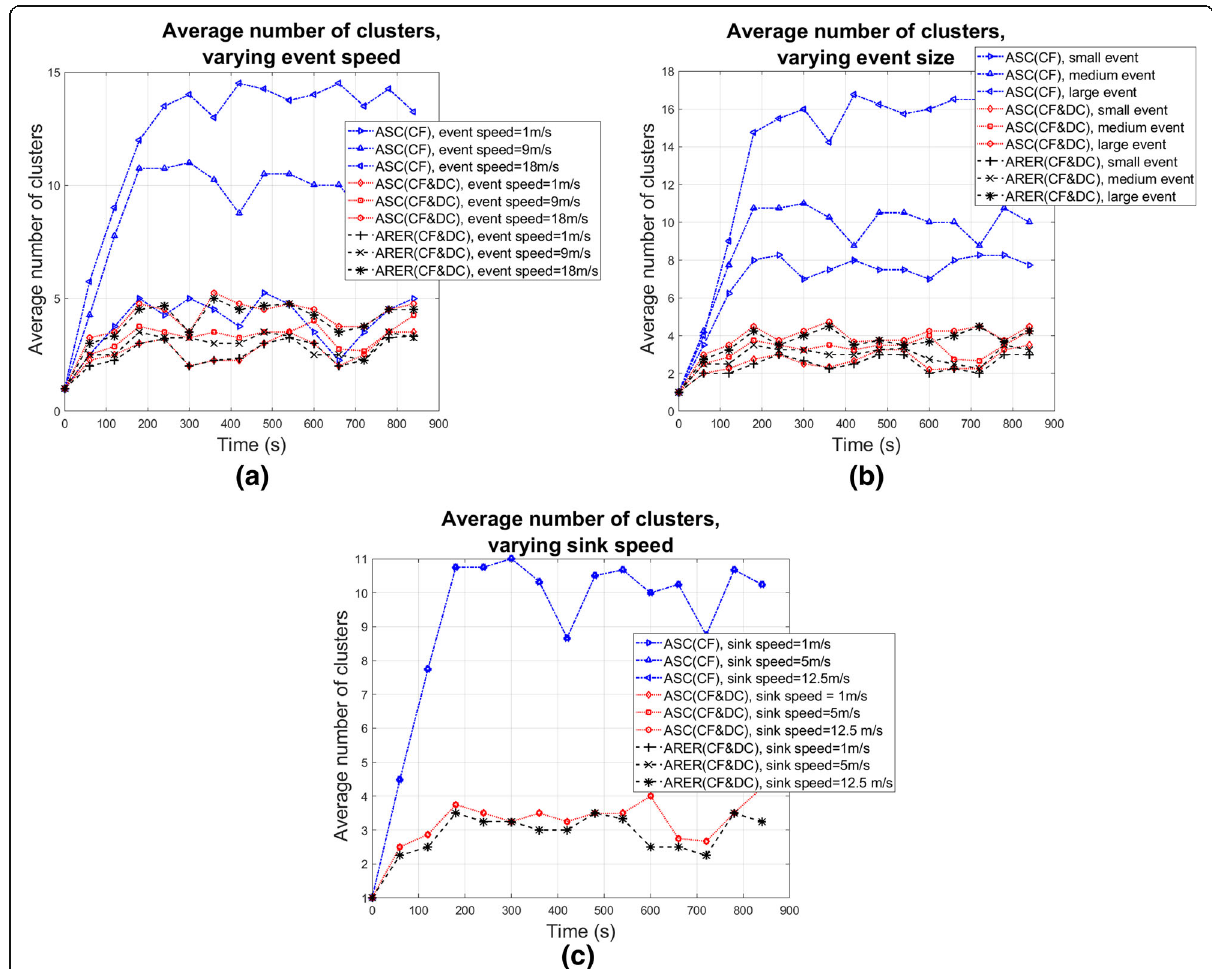
Fig. 7 Average number of clusters in the network. a Different event speeds. b Different event sizes. c Different sink speeds